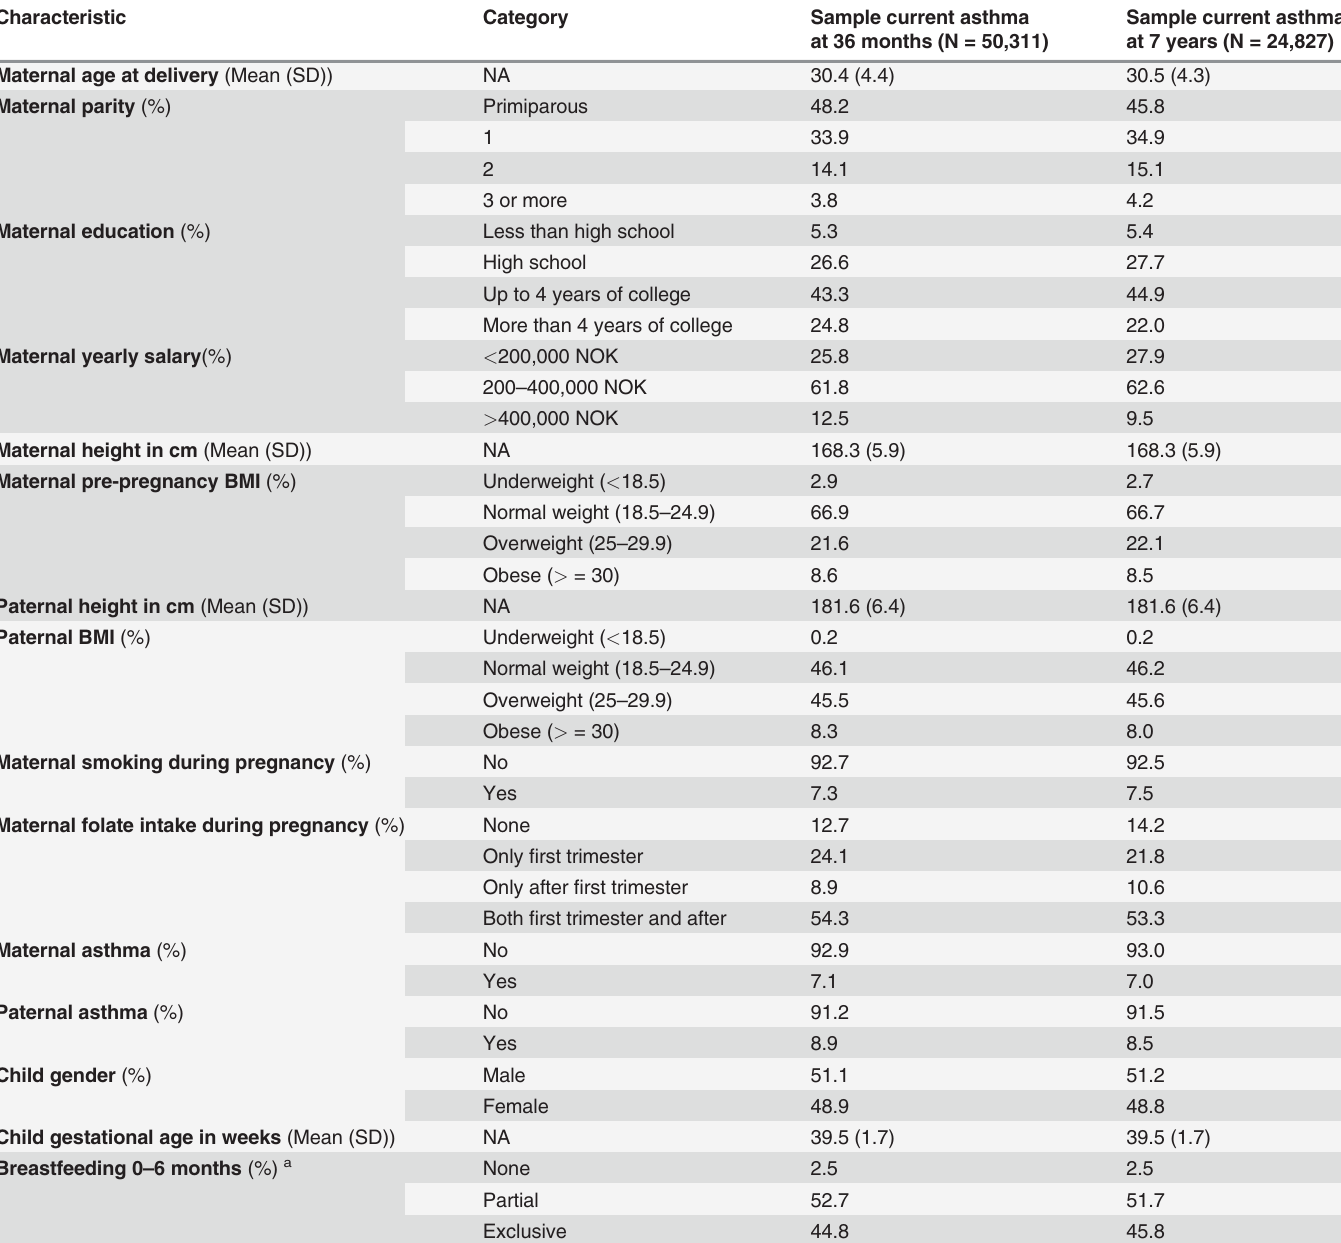
Table 1. Distribution of characteristics among individuals with follow-up information available for the analysis of asthma at 36 months and current asthma at 7 years.